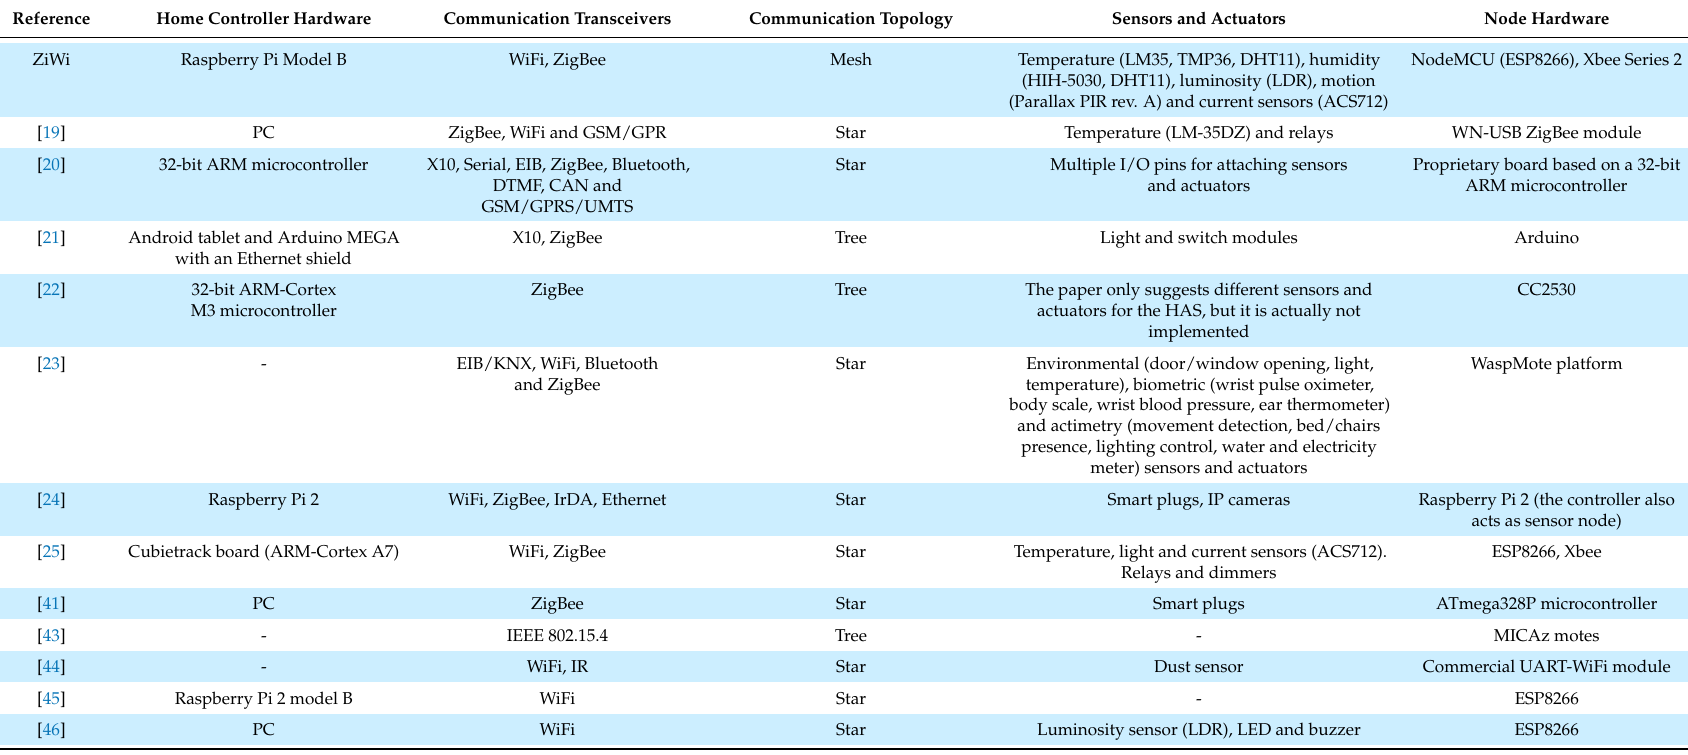
Table 3. Comparison of the main features of the most relevant academic HAS and the proposed system (part